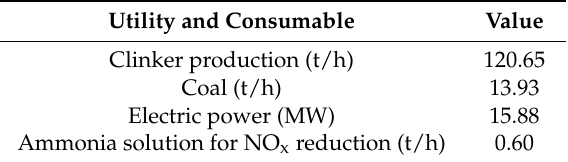
Table 1. Utilities and consumables for the reference cement plant without CO 2